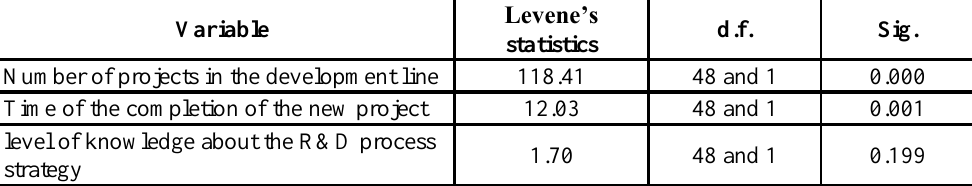
Table 12. Levene’s test f r